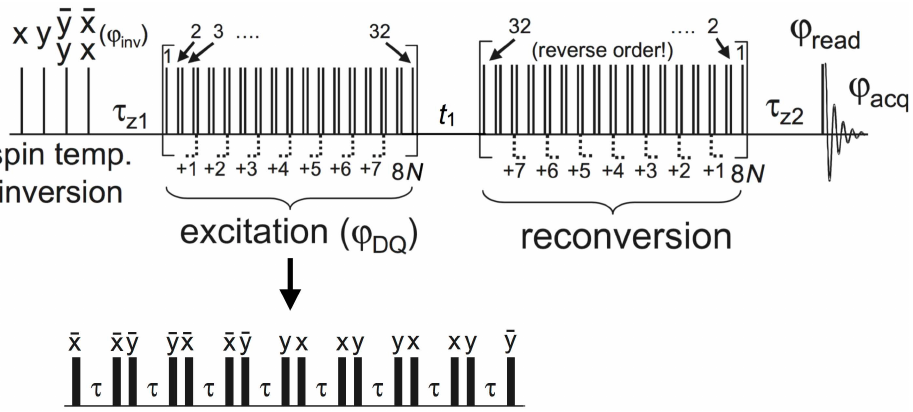
Figure 15. BaBa-xy16 pulse sequence as introduced in ref. [102]. All black bars symbolize 90 ◦ pulses. The pulse phases φ i are varied as described in the text. Figure reproduced with permission from [102]. Copyright 2011